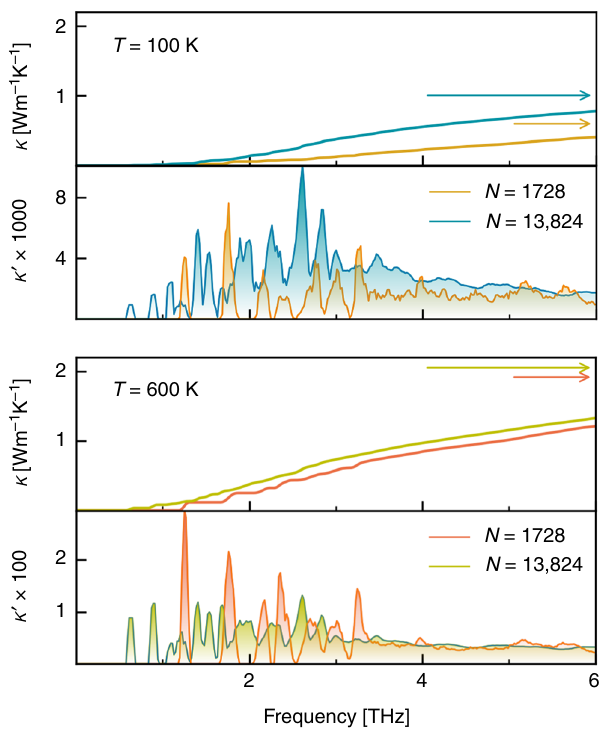
Fig. 3 Thermal conductivity accumulation function. Conductivity accumulation function, κ ( ω ), and frequency-resolved differential conductivity, κ ′ ( ω ) (Eqs. (10) and (11)), computed for two different model sizes ( N = 1,728 and N = 13,824 atoms) at temperatures T = 100 K and T = 600 K. Horizontal arrows in the upper panels indicate cumulative values of κ . κ ′ is in units of WK − 1 m − 1